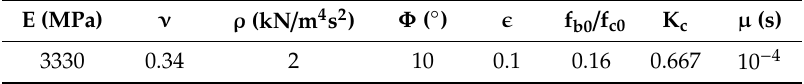
Table 3. Data defining the mechanical behavior and the damage model: E—Young’s